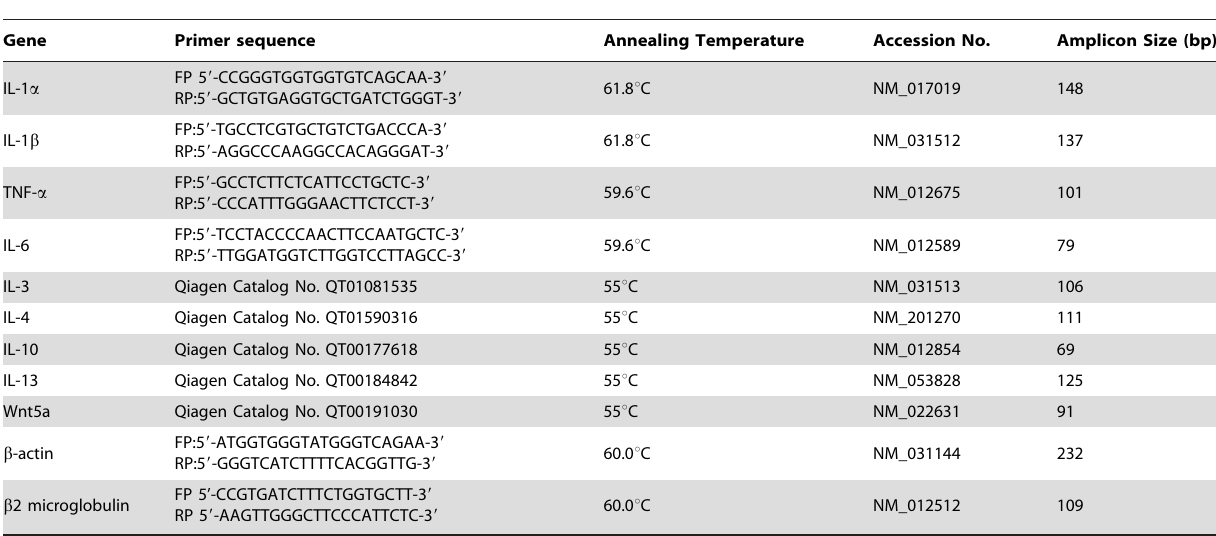
Table 2. Sequences of forward (FP) and reverse primers